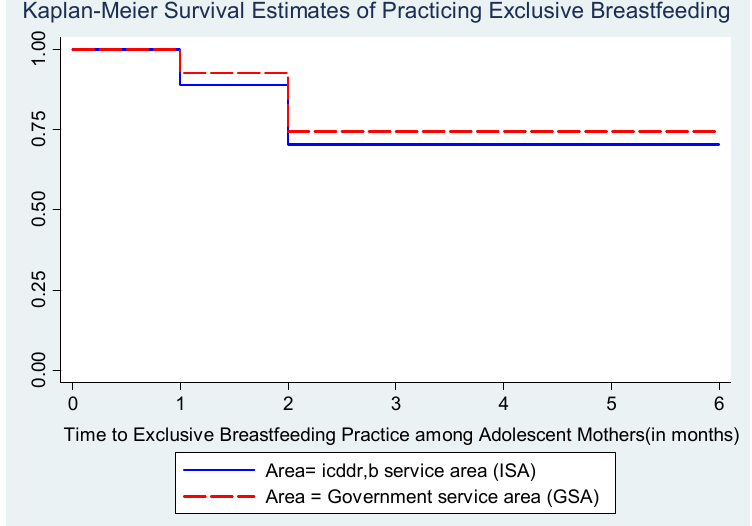
Figure 3. Kaplan–Meier survival estimates for time to EBF in icddr,b service area (ISA) and government service area (GSA).